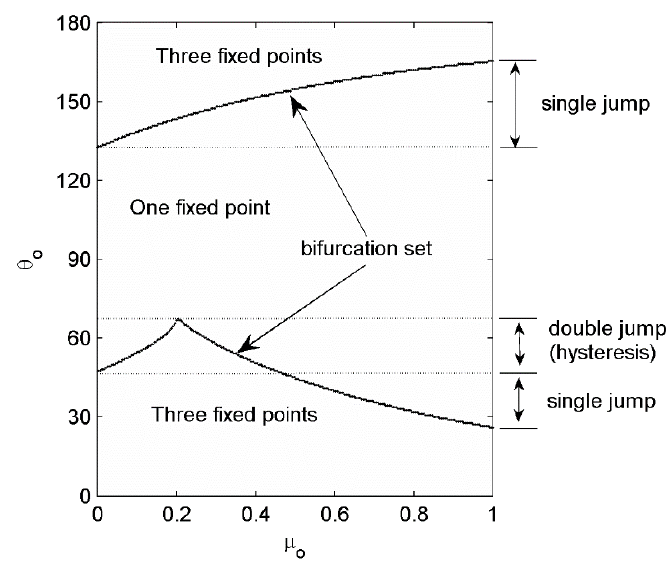
Figure 12. Bifurcation set (curve) and catastrophe for steady-sliding equilibrium at σ = 0.1.